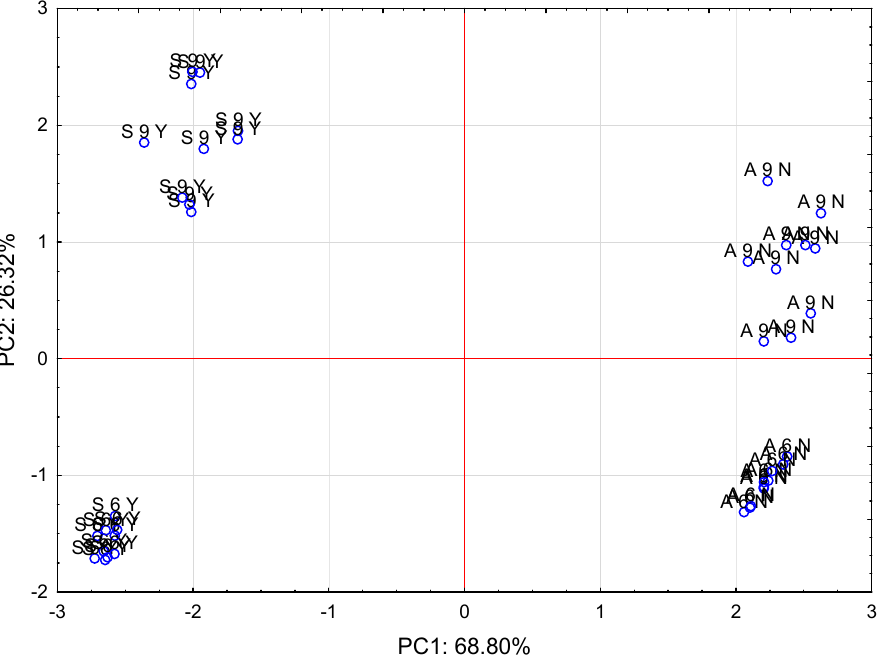
Figure 3. Puncture test carried out in September for the seed capsule of ( a ) I. aphylla and ( b ) I. sibirica and for the seeds of ( c ) I. aphylla and ( d ) I. sibirica .